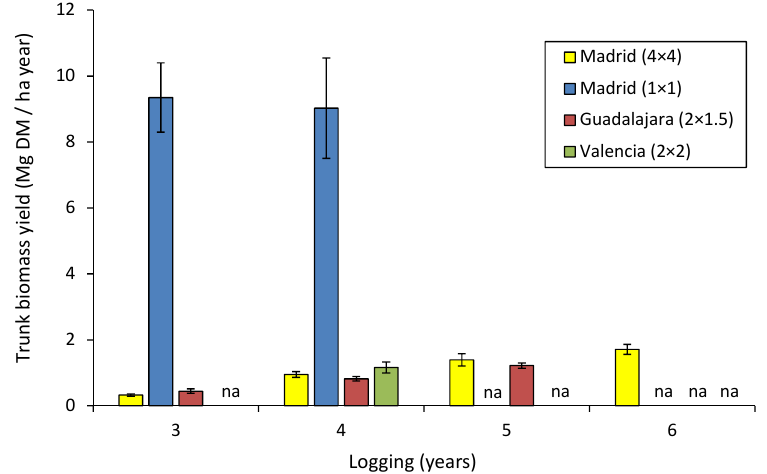
Figure 4. Estimated trunk biomass yield of Ademuz elm clone in the four experimental plots and in different harvesting years. na = data not available. Vertical bars indicate standard errors.